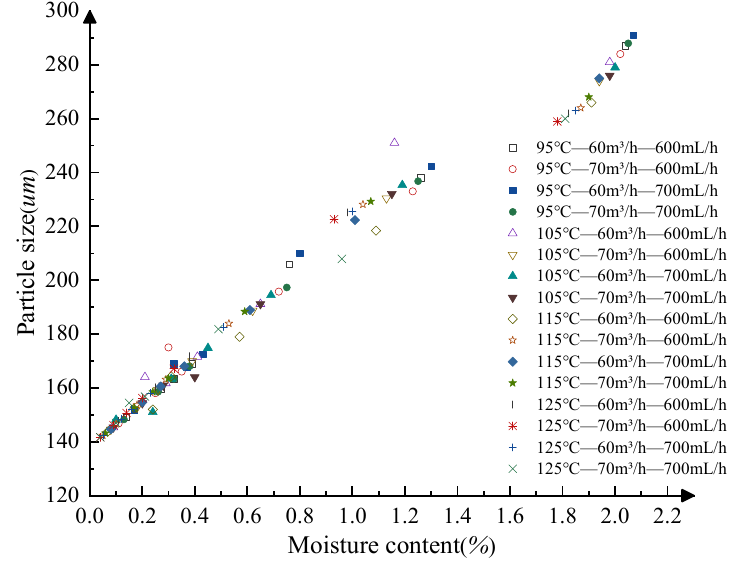
Figure 6. Variation of yeast particle size with moisture content.